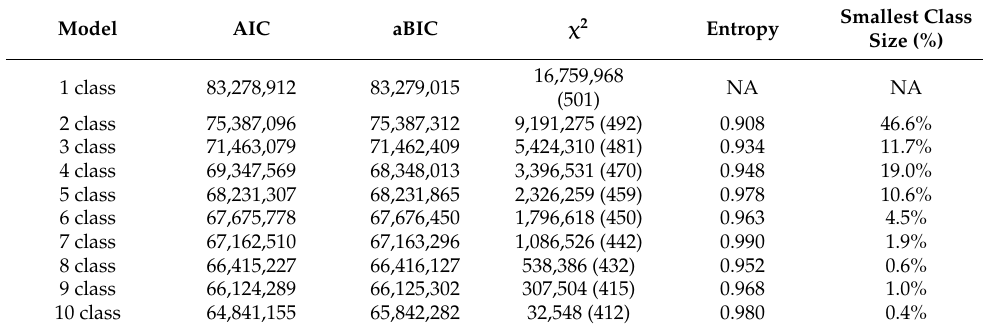
Table 1. Information criterion for all